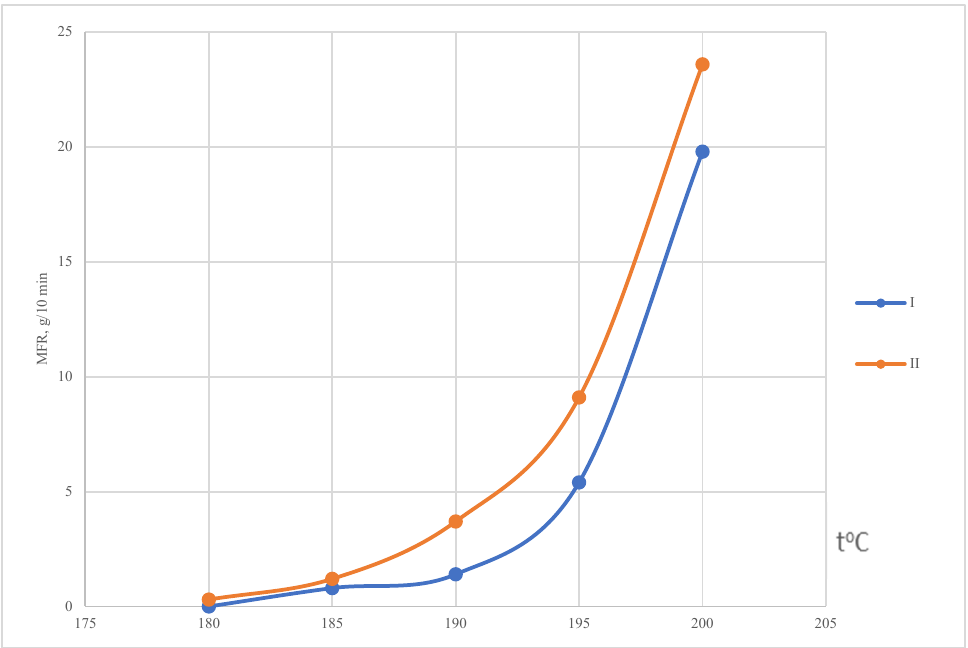
Figure 6. Dependence of the MFR of PVC composition on temperature. I, II—Symbols of plasticizers (Table 5).